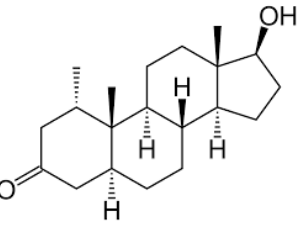
Figure 27. Chemical structure of mesterolone. Formula: C 20 H 32 O 2 .